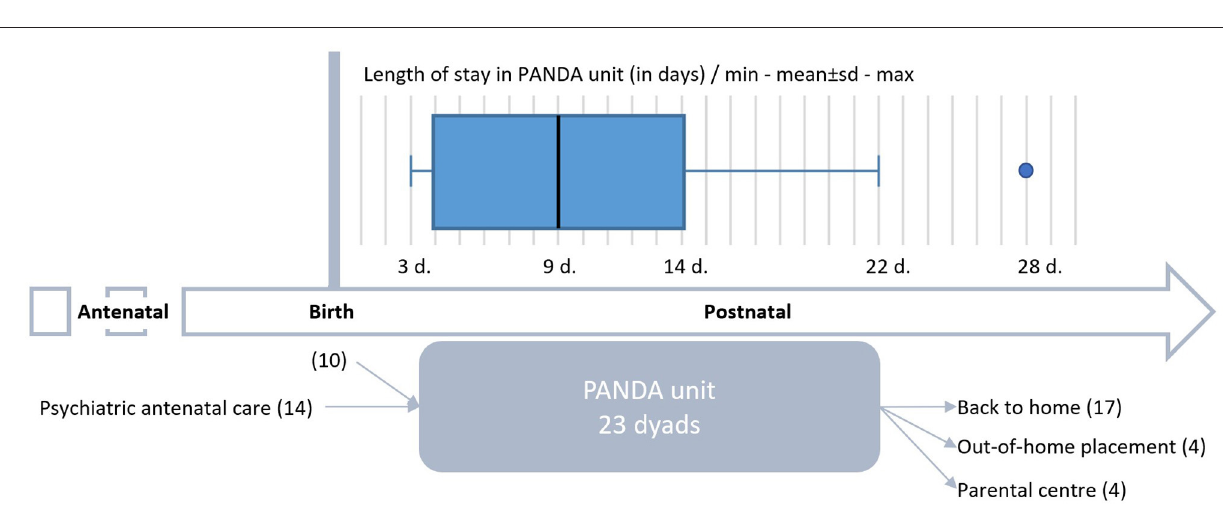
FIGURE 2 | Overview of the PANDA hospitalization course of the first 24 dyads from inclusion to the end of